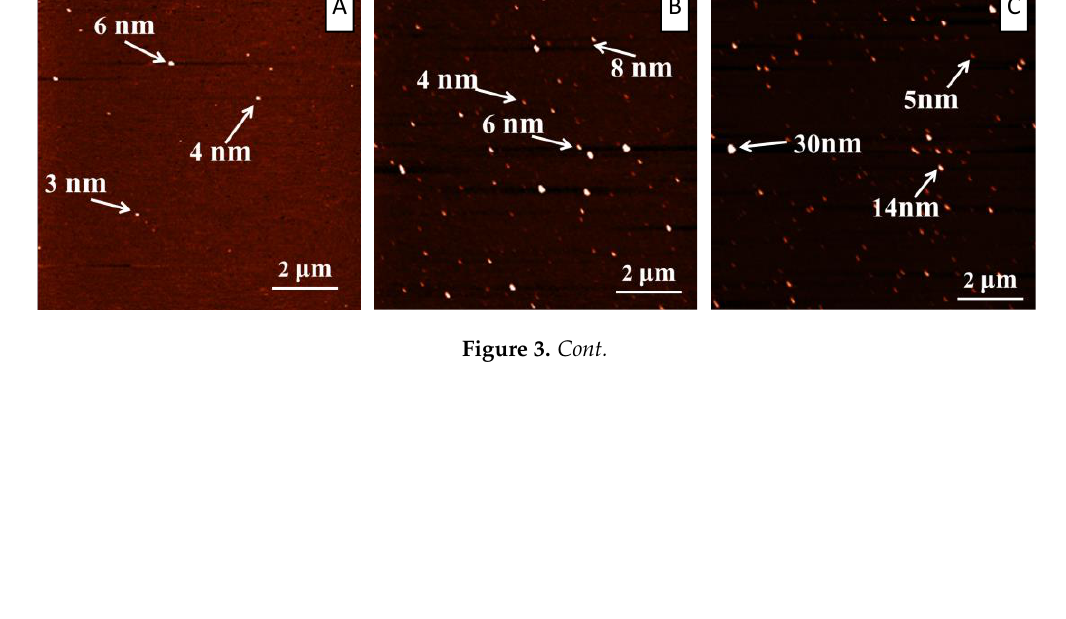
Figure 3. Atomic force microscopy (AFM) characterizations of lysozyme fibrillation under the influence of different concentrations of tannic acid at t = 0 h during incubation. ( A ) Control; ( B ) 150 µM; ( C ) 300 µM; ( D ) 600 µM; ( E ) 900 µM; ( F ) 1200 µM. Figure 4. AFM characterizations of lysozyme fibrillation under the influence of different concentrations of tannic acid at the end of the incubation. ( A ) Control; ( B ) 150 µM; ( C ) 300 µM; ( D ) 600 µM; ( E ) 900 µM; ( F ) 1200 µM. In the following, we propose a hypothesis to interpret the observed modulation behavior of tannic acid on amyloid fibrillation based on surface-catalyzed nucleation theory. As we mentioned